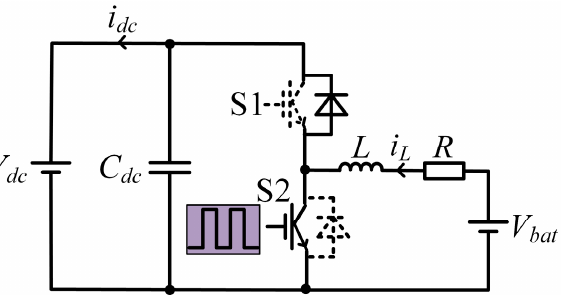
Figure 4. Principle diagram of bidirectional DC/DC converter working in boost mode.